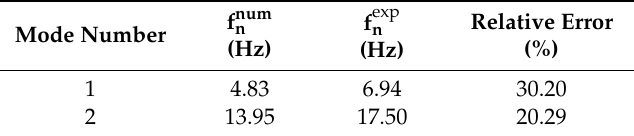
Table 4. Values of experimentally-measured natural frequencies and computed frequencies (f num n ) for the updated numerical model.